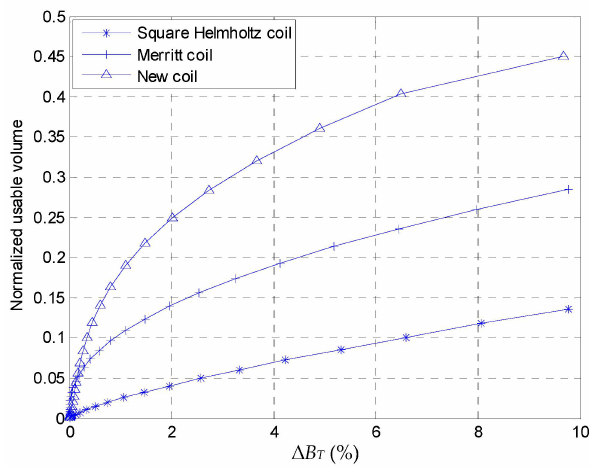
Figure 8. Comparison of usable volume as a function of total deviation rate ( ∆ B T